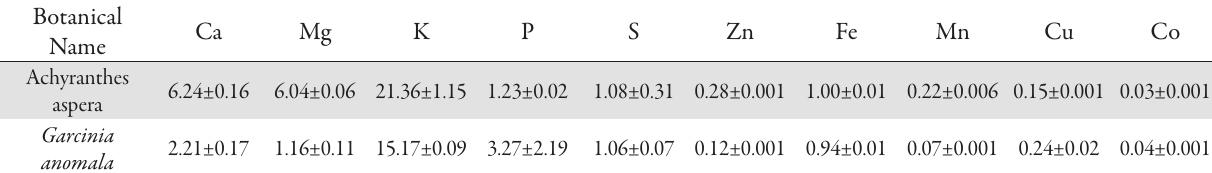
Tab. 4. Micro- and micro-element contents (mg/g) of the two plants used as mordant (Mean± S. Em)